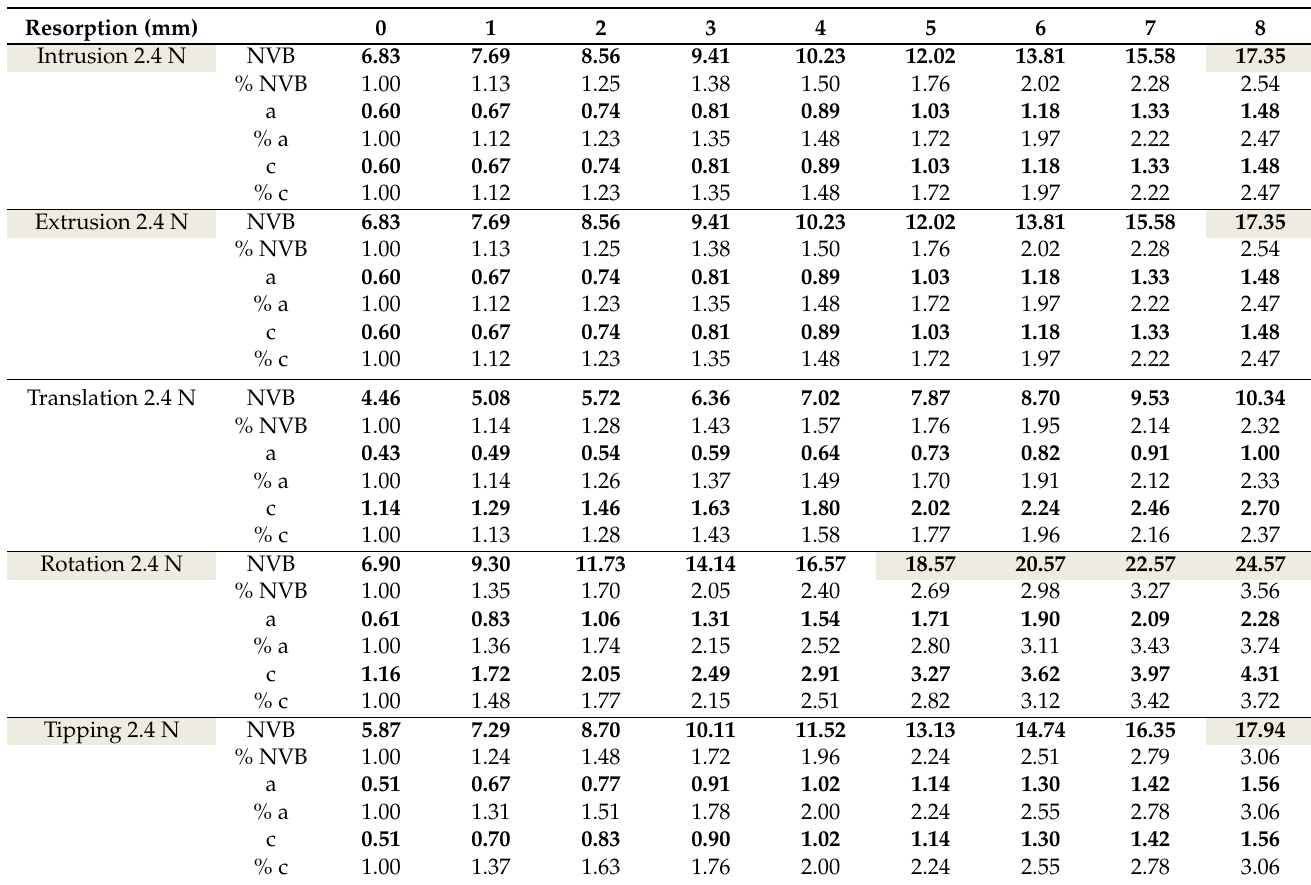
Table 4. The Tresca shear-stress average values (KPa) produced by 2.4 N of orthodontic